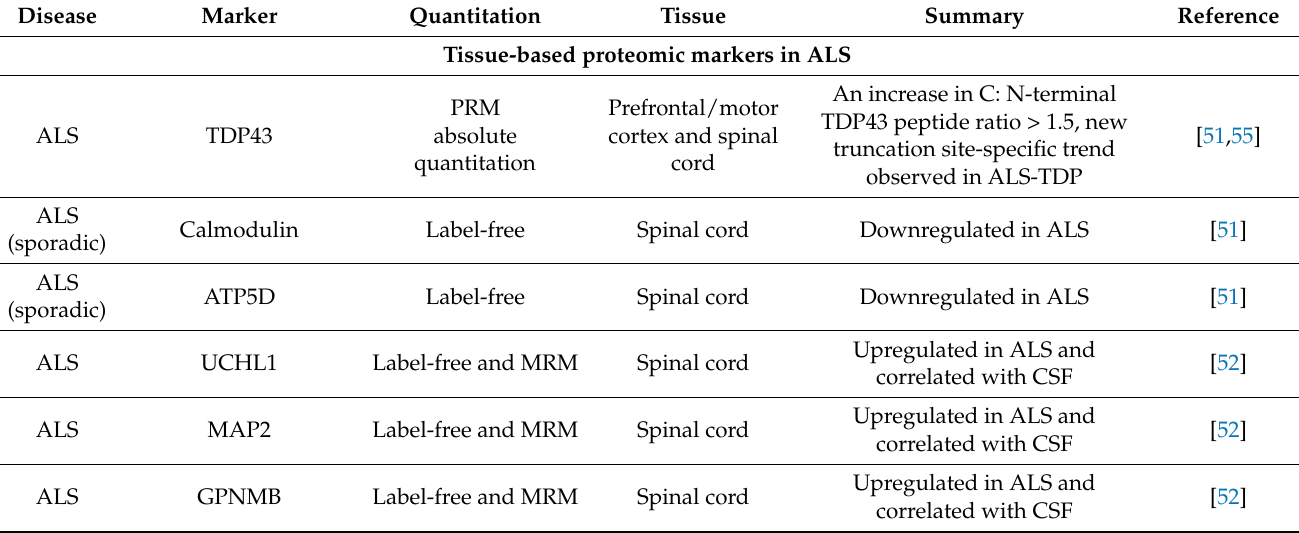
Table 2. Proteomic studies in ALS focused on biomarker